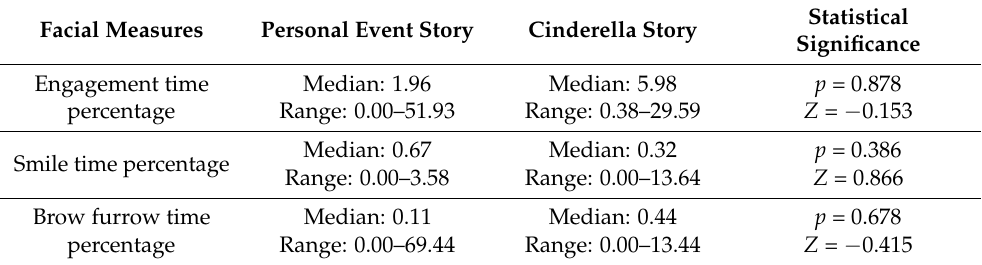
Table 9. Comparison between narrative tasks for the control